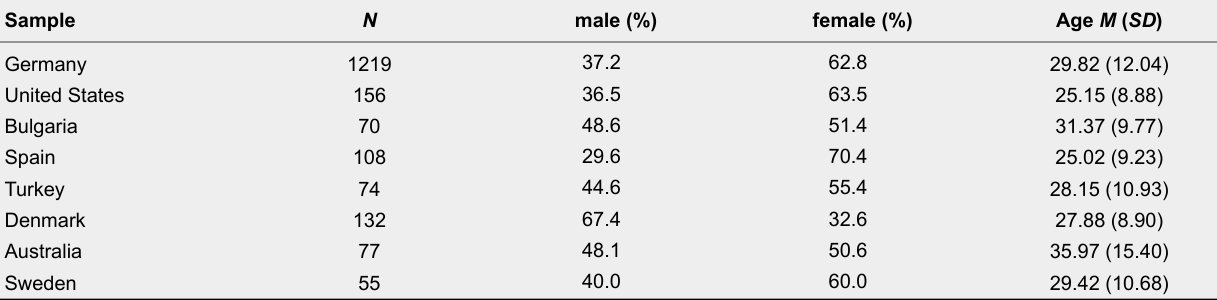
Distribution of Gender and Age in All Samples